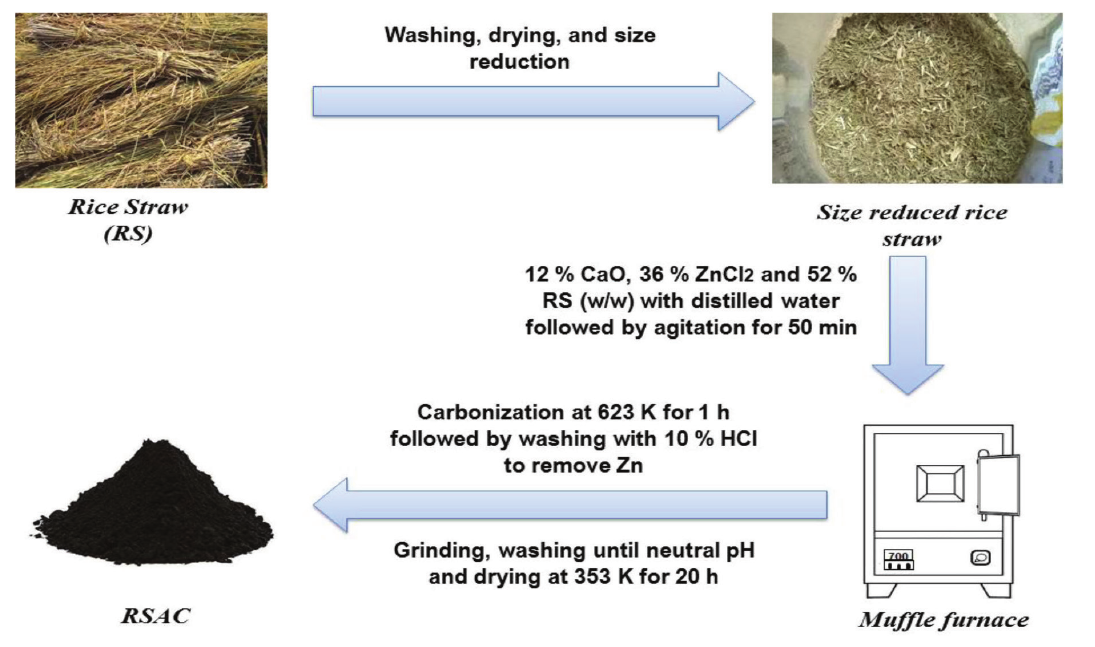
Fig. 1 – Schematic representation of RSAC